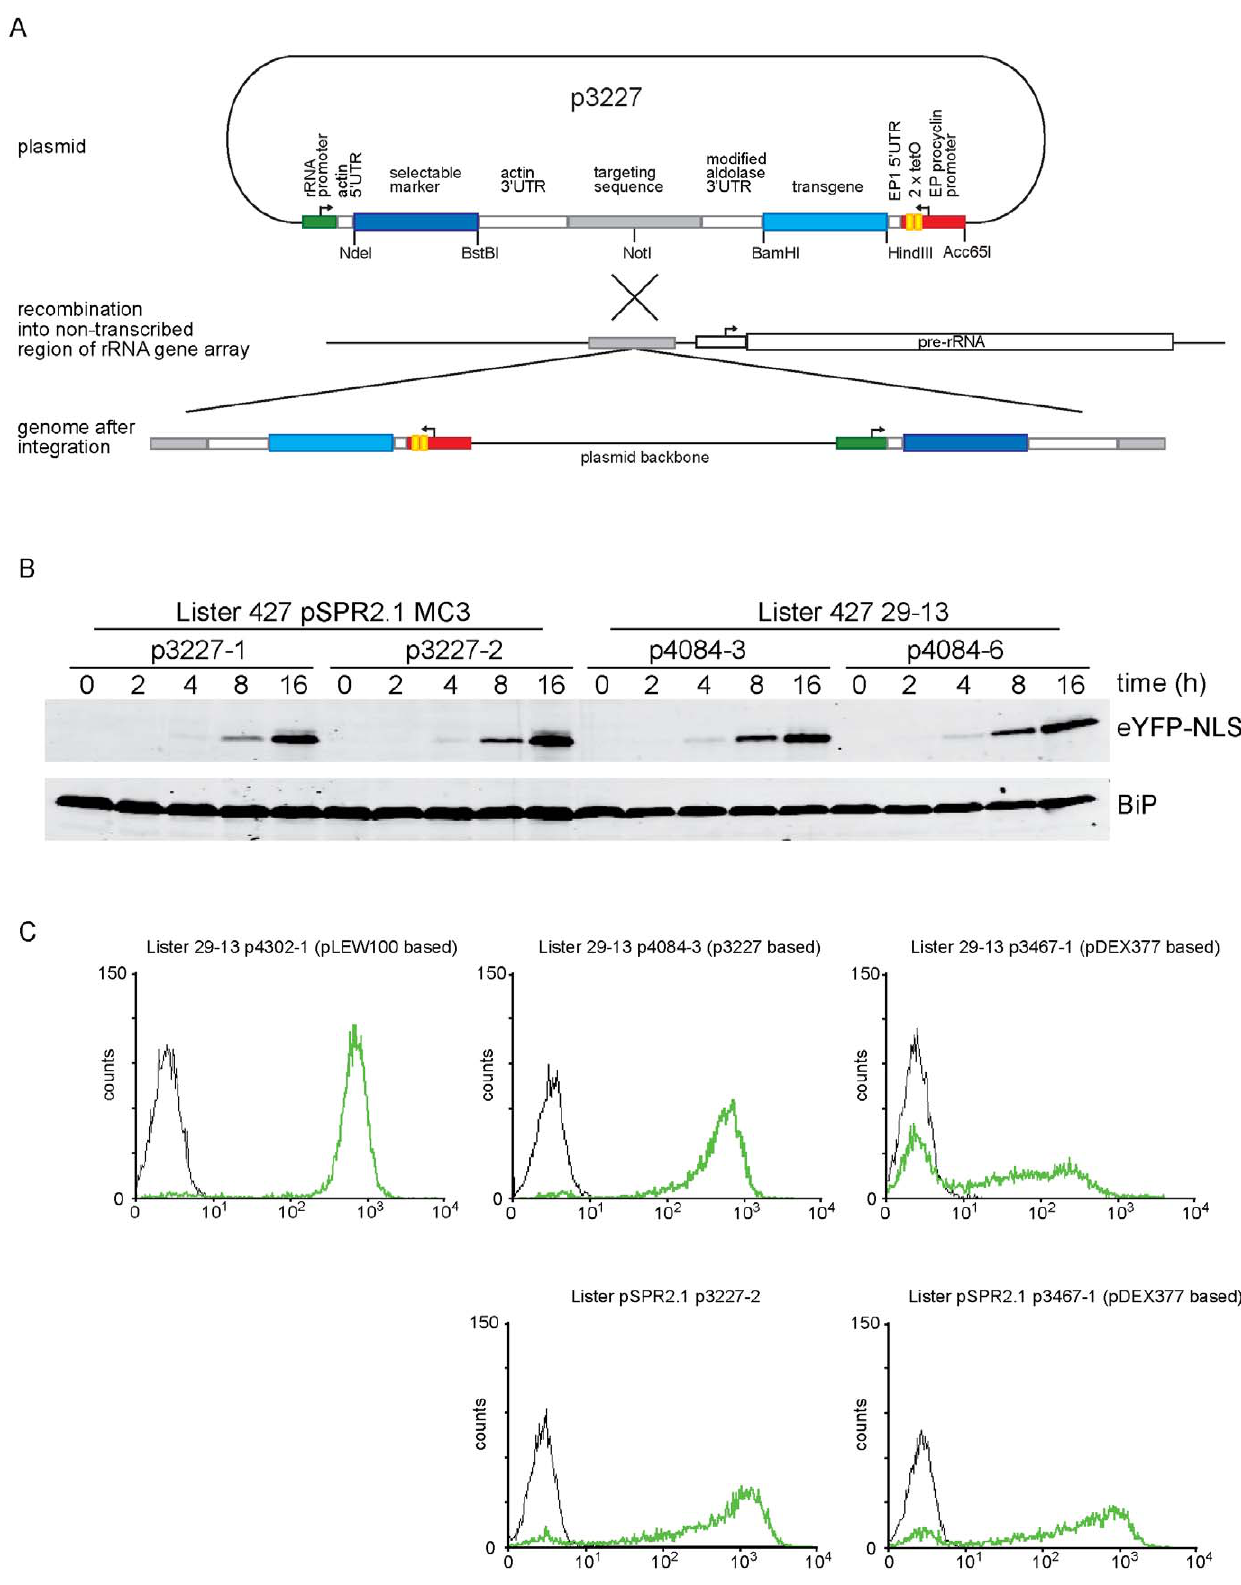
Figure 2. p3227 supports tetracycline inducible expression. (A) Diagram of p3227 and its integration into the non-transcribed spacer in a tandem array of rRNA genes after digestion with NotI. The other unique restriction sites shown allow the replacement of the promoter, transgene and selectable marker. (B) Western blot probed with anti-GFP and anti-BiP (loading control) showing eYFP-NLS expression during a time course after induction in SPR2.1 and 29-13 cell lines. (C) Flow cytometry measurement of eYFP-NLS levels in individual cells from representative clones in which the different plasmids were induced with tet (green line) or without (black line) for 18 hours. doi:10.1371/journal.pone.0035167.g002 PLoS ONE |